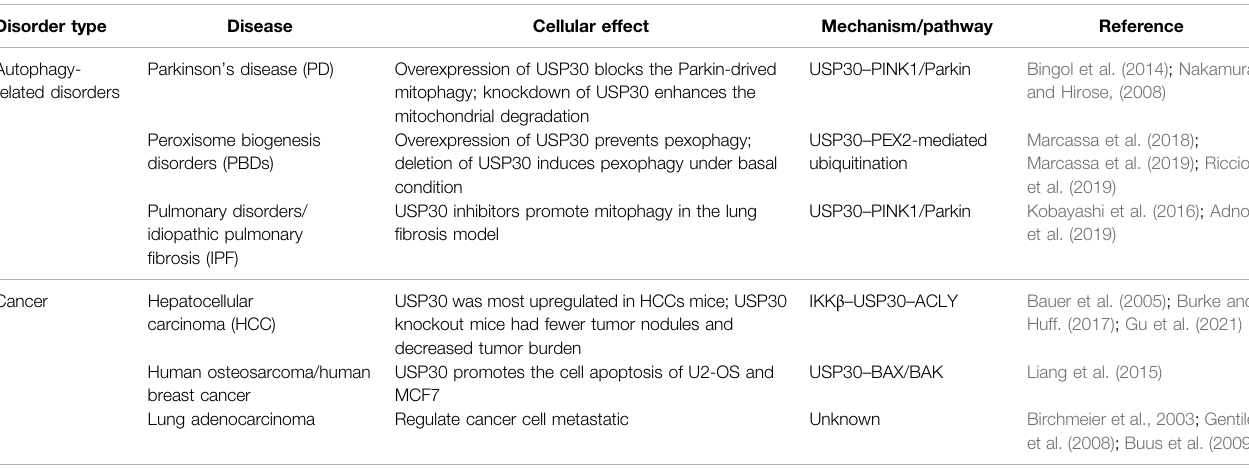
TABLE 1 | Physiological role of USP30 in cancer and autophagy-related